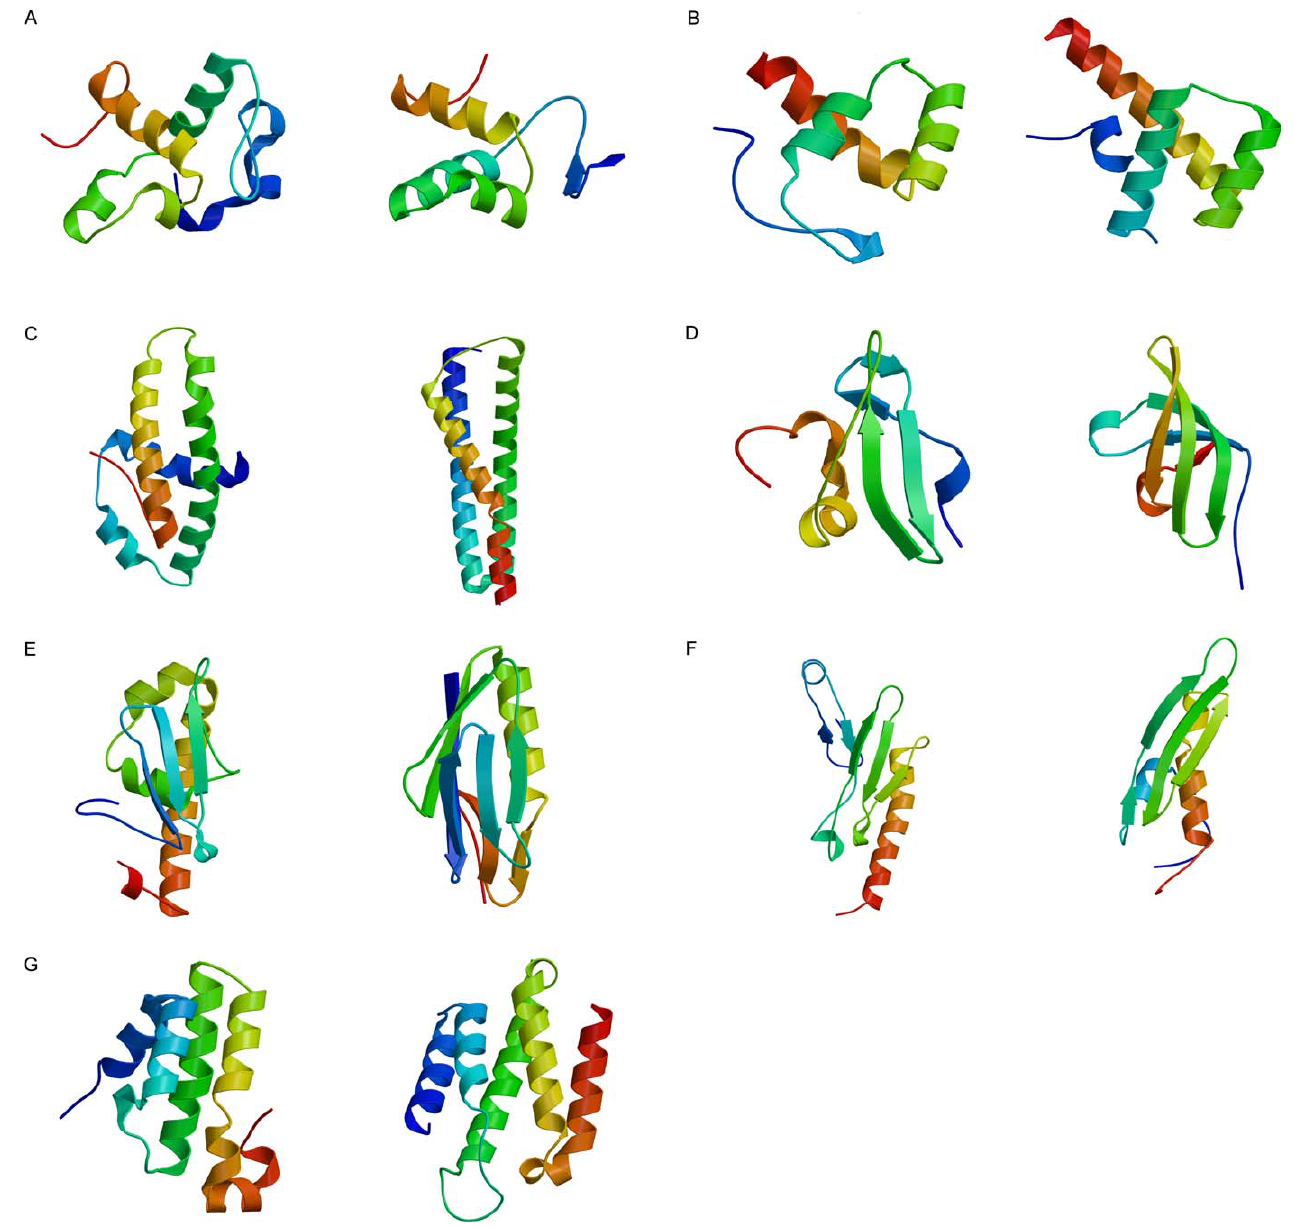
Figure 5. Structure Predictions with High P (SF j D,GO) The predicted structure with the highest P (SF j D,GO) (left) is shown for (A) ROX3, (B) MED4, (C) GAL11, (D) TIF35, (E) MRPL37, (F) MRPL44, and (G) INH1 displayed next to the matching SCOP representative